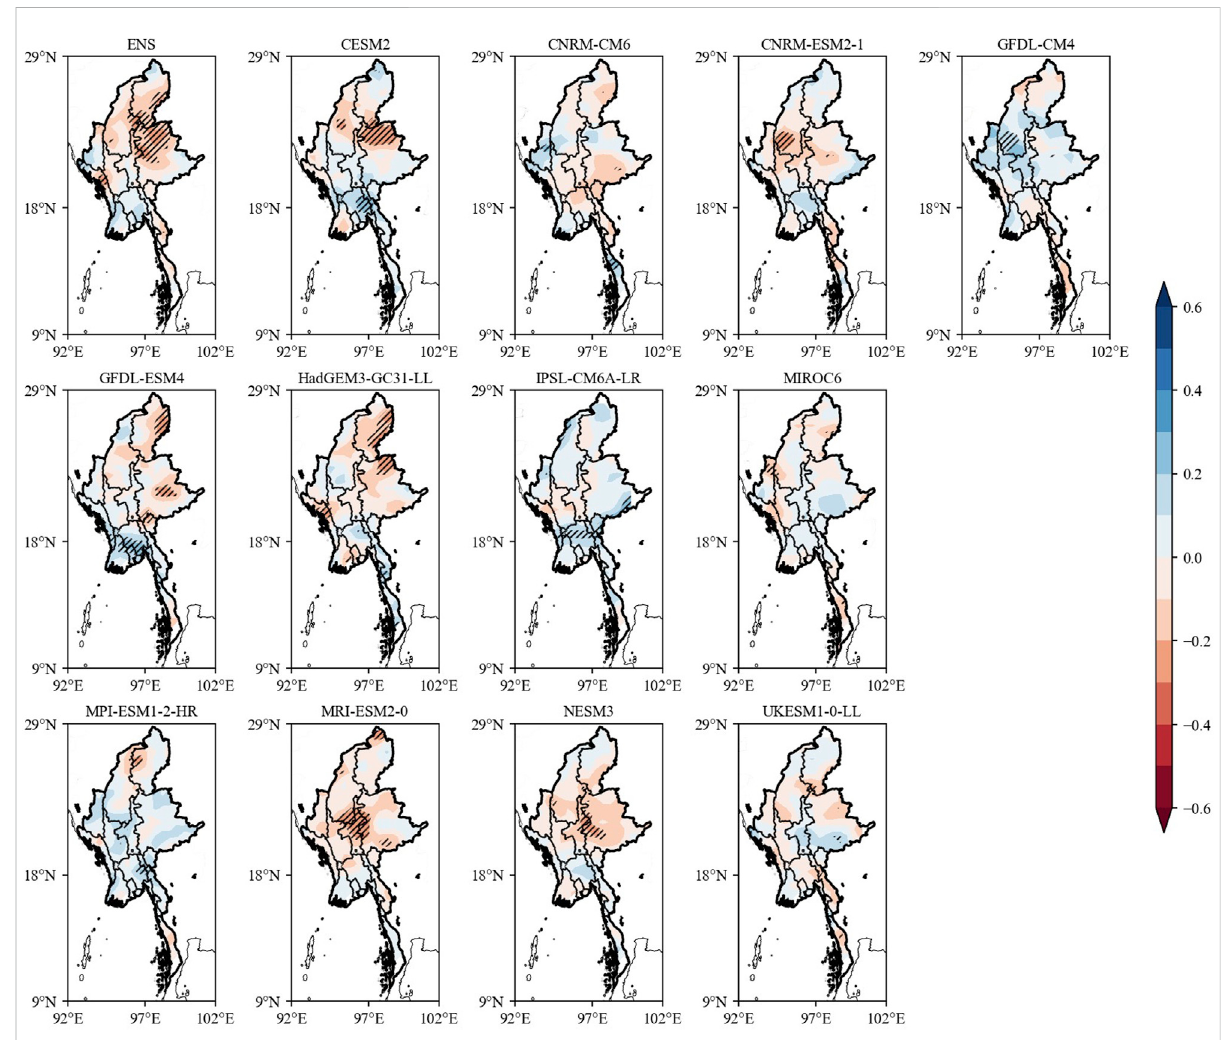
FIGURE 9 Spatial distribution of correlation coef fi cient of seasonal GPCC PRE (MJJASO) with the 12 CMIP6 models. Hatches indicate signi fi cance at the 90% con fi dence